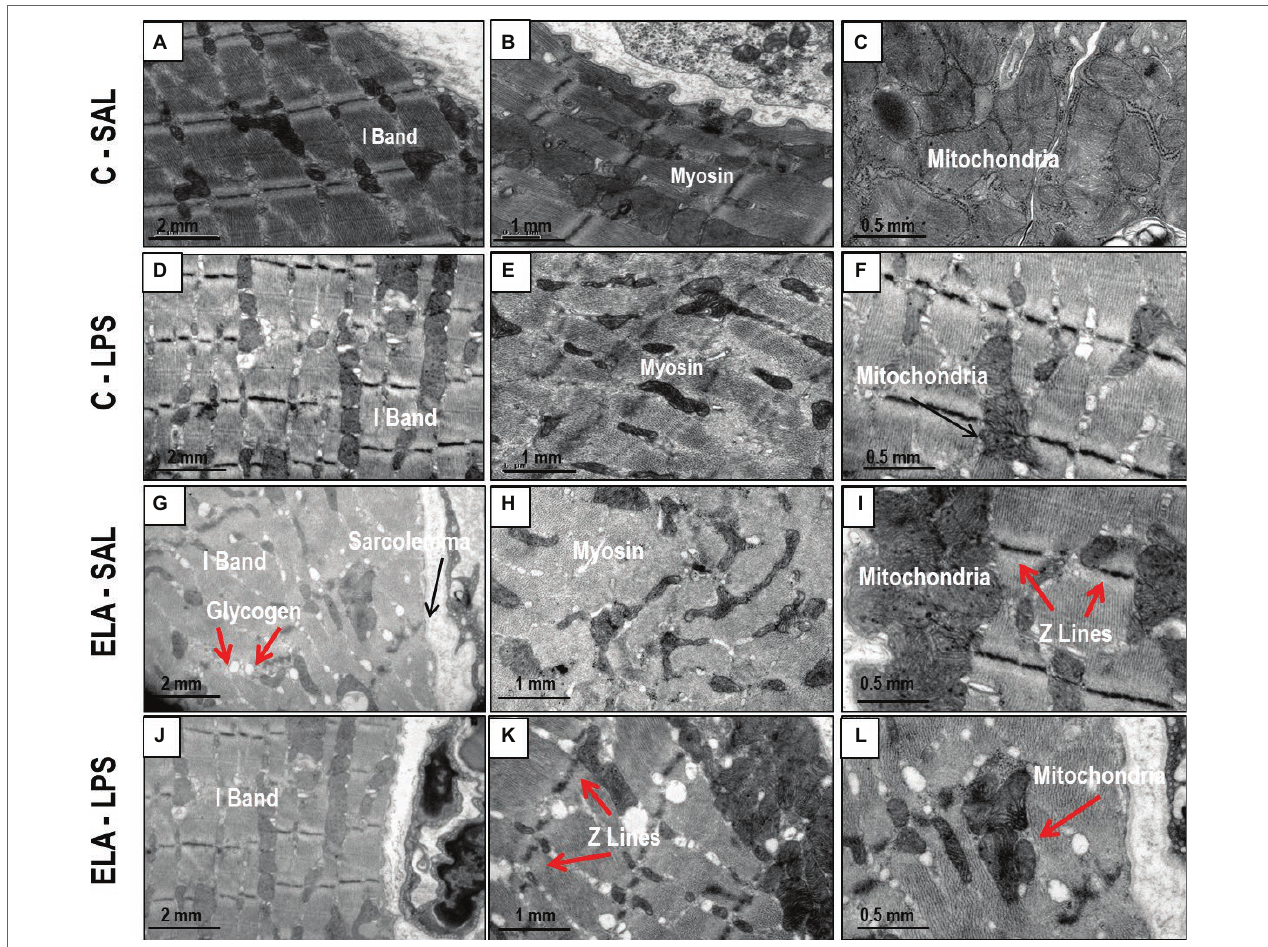
FIGURE 9 | Transmission electron microscopy of diaphragm in control (C) animals treated with saline (A–C) or E. coli LPS (D–F) , as well as in emphysema (ELA) animals treated with saline (G–I) or E. coli LPS (J–L) . Note I-band integrity and preserved myosin and mitochondria in C-SAL group. The C-LPS group shows discrete changes in these structures. The ELA-SAL group exhibits disorganized I-bands, glycogen accumulation in sarcoplasm, loss of myosin content in myofibrils, subsarcolemmal mitochondrial aggregates, and thickened Z lines. The ELA-LPS group shows even more intense changes in these